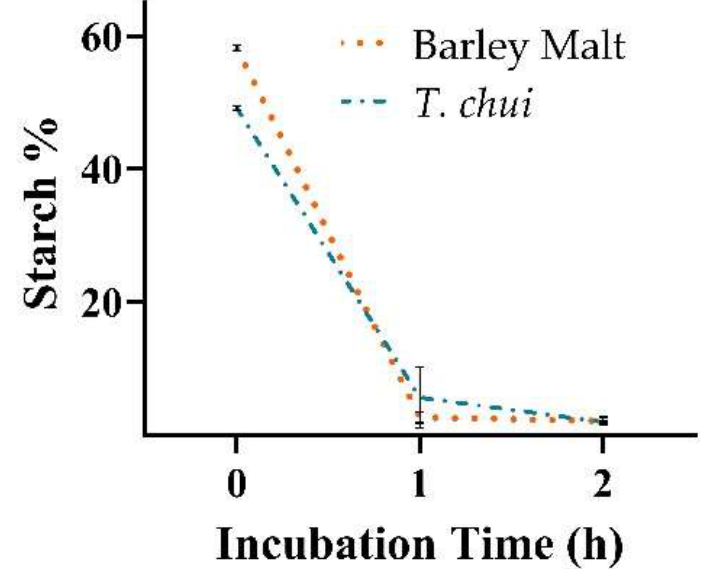
Figure 3. Starch degradation in barley malt (dotted line) and T. chui (dashed line) biomass by enzyme-rich wort at 67 ◦ C incubation over two hours. All data represent mean ± SD of triplicate meas- urements.